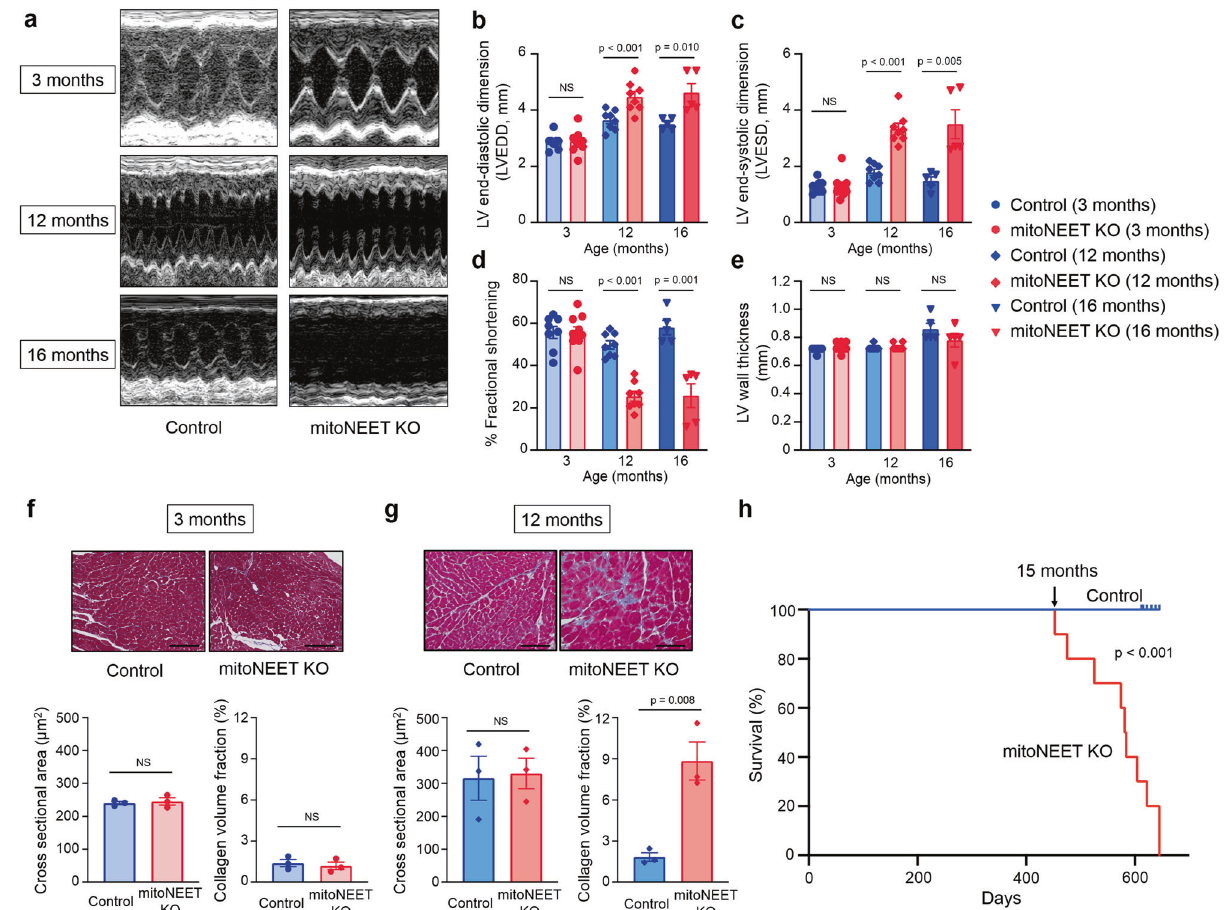
Fig. 2 Cardiac-speci fi c mitoNEET KO mice demonstrate LV dysfunction, HF, and HF death with chronological aging. Representative echocardiographic images ( a ) and summary data of left ventricular end-diastolic dimension (LVEDD) ( b ), left ventricular end-systolic dimension (LVESD) ( c ), % fractional shortening ( d ), and LV wall thickness ( e ) in Control and mitoNEET KO mice at 3 months ( n = 8 and 9, respectively), 12 months ( n = 8 and 9, respectively), and 16 months of age ( n = 5 each). Representative Masson trichrome staining and summary data of the cross-sectional area and collagen volume fraction of Control and mitoNEET KO mice at 3 months ( f ; n = 3 each) and 12 months ( g ; n = 3 each) of age. Scale bar, 100 μ m. Kaplan – Meier survival curves of Control ( n = 10) and mitoNEET KO mice ( n = 10) ( h ). Arrow indicates the point of 15 months. Data are shown as the mean ± s.e.; individual points are shown. The Student unpaired two-tailed t -test was performed to compare means between Control and mitoNEET KO mice of identical age. The differences between Control and mitoNEET KO mice in survival were tested by the log-rank test. NS, not signi fi